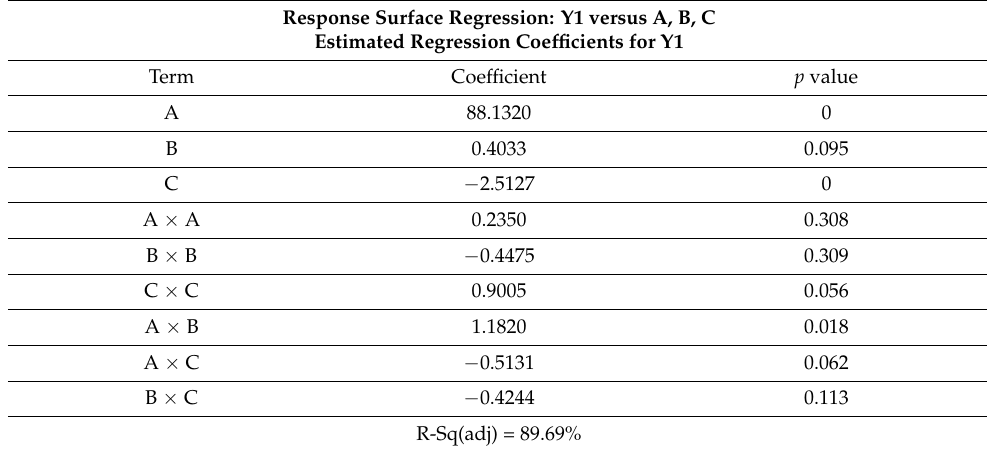
Table 4. Experimental regression analysis for the field synergy angle.